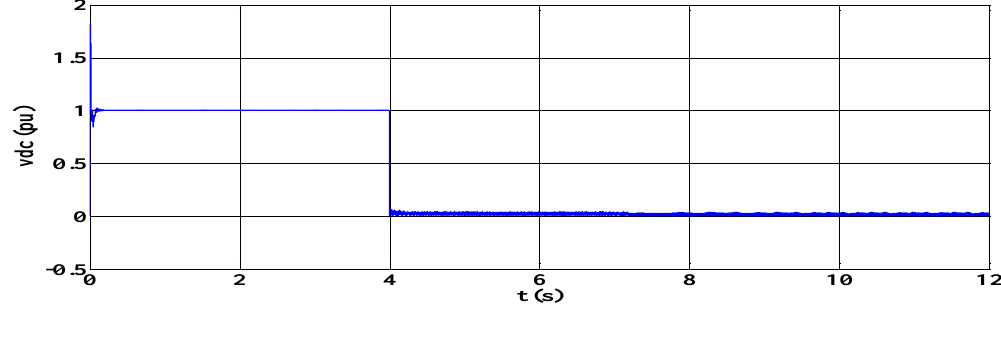
Figure 32. DC link voltage (short-circuit happens at t = 4 s).